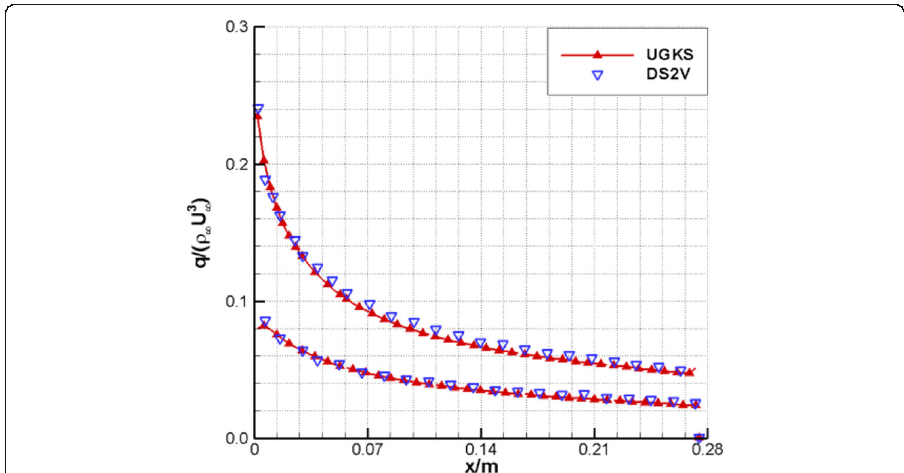
Fig. 6 Heat flux distribution on the wedge